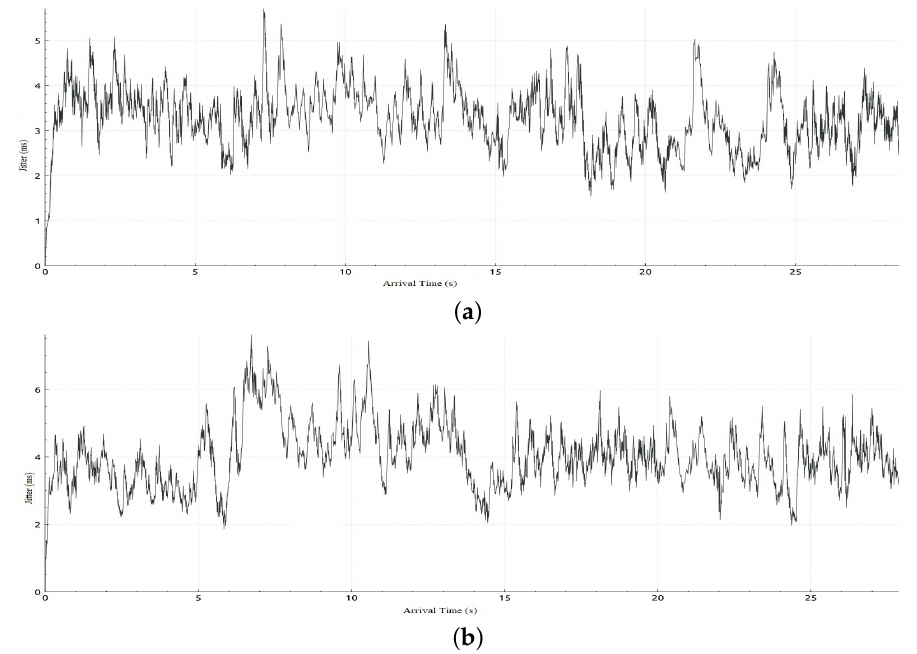
Figure 11. Jitter obtained in Scenario 2 in case of applying and without applying proposed adaptive QoS model for 30-s video streaming traffic flow, ( a ) jitter obtained in Scenario 2 in case of applying proposed model, ( b ) Jitter obtained in Scenario 2 without applying proposed adaptive QoS model.